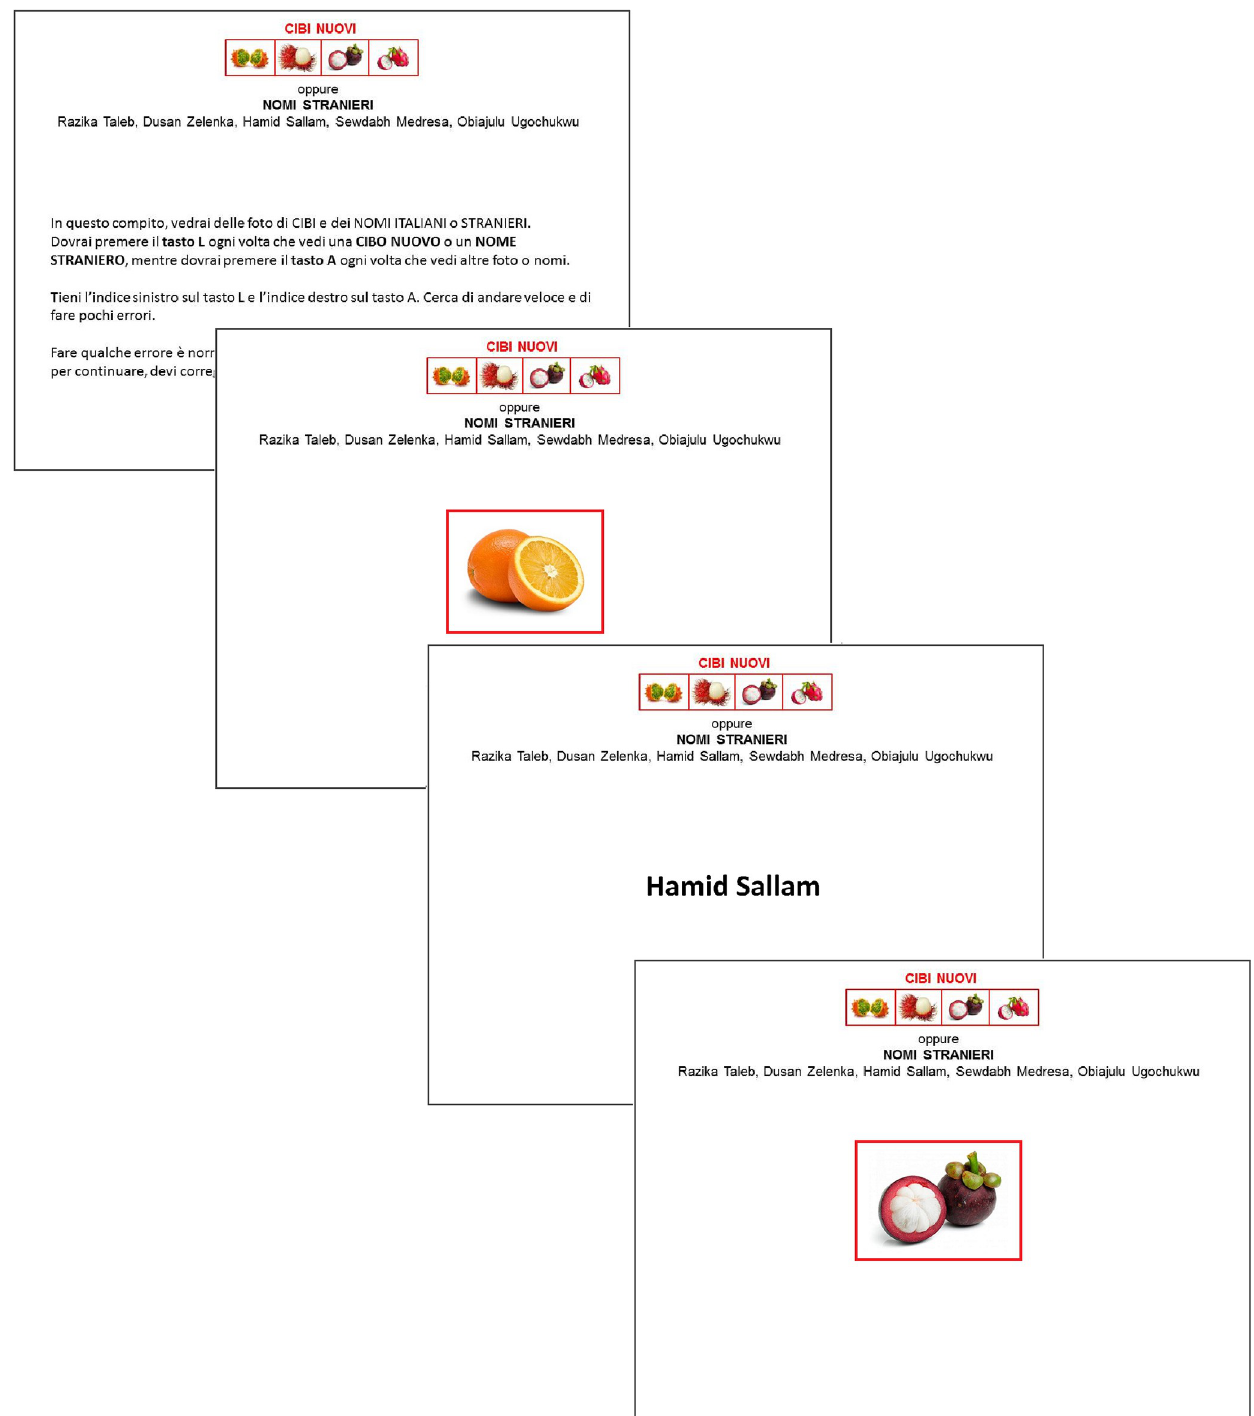
Fig 1. Examples of some BIAT trials. In this block, participants were asked to categorize stimuli by pressing the L key for both novel food pictures and foreigner names and the A key for all other stimuli.